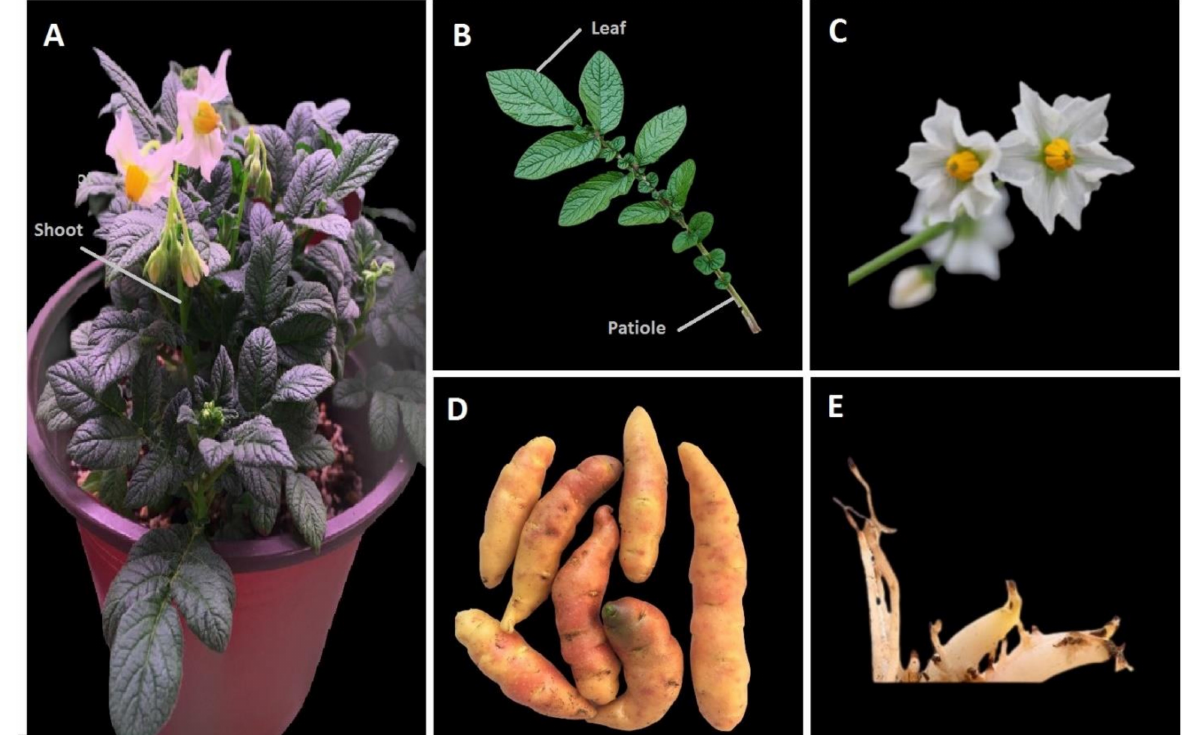
Figure 1. Potato plant tissues used for gene expression analysis. ( A ) Shoots, ( B ) patiole, ( C ) flower, ( D ) tuber, ( E )